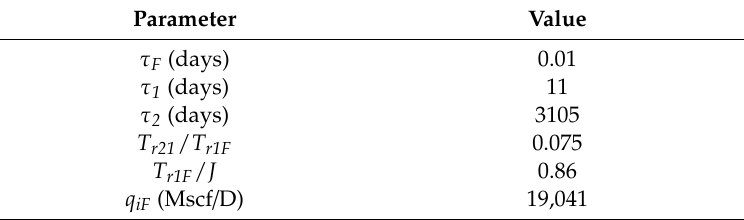
Table 7. Model parameters used in the analytical model for application in the field